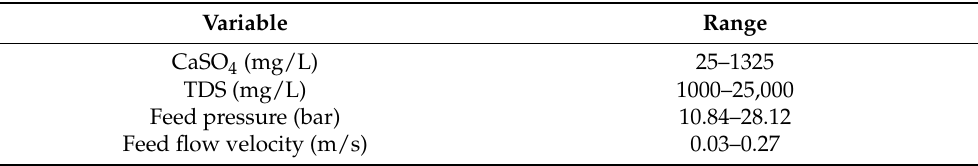
Table 2. Range of operating variables used in CFD